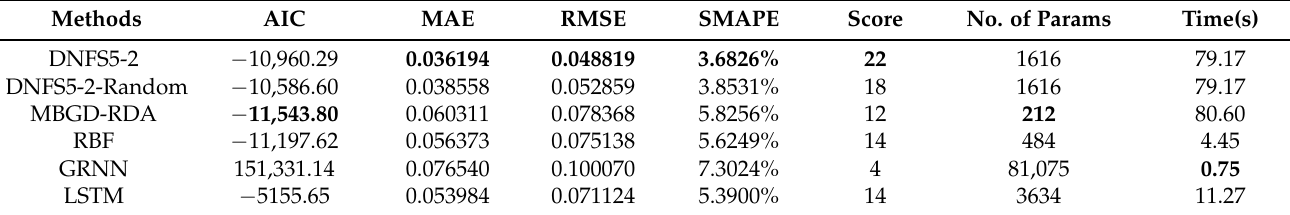
Table 8. The performance of different algorithms on Test Dataset No. 1.